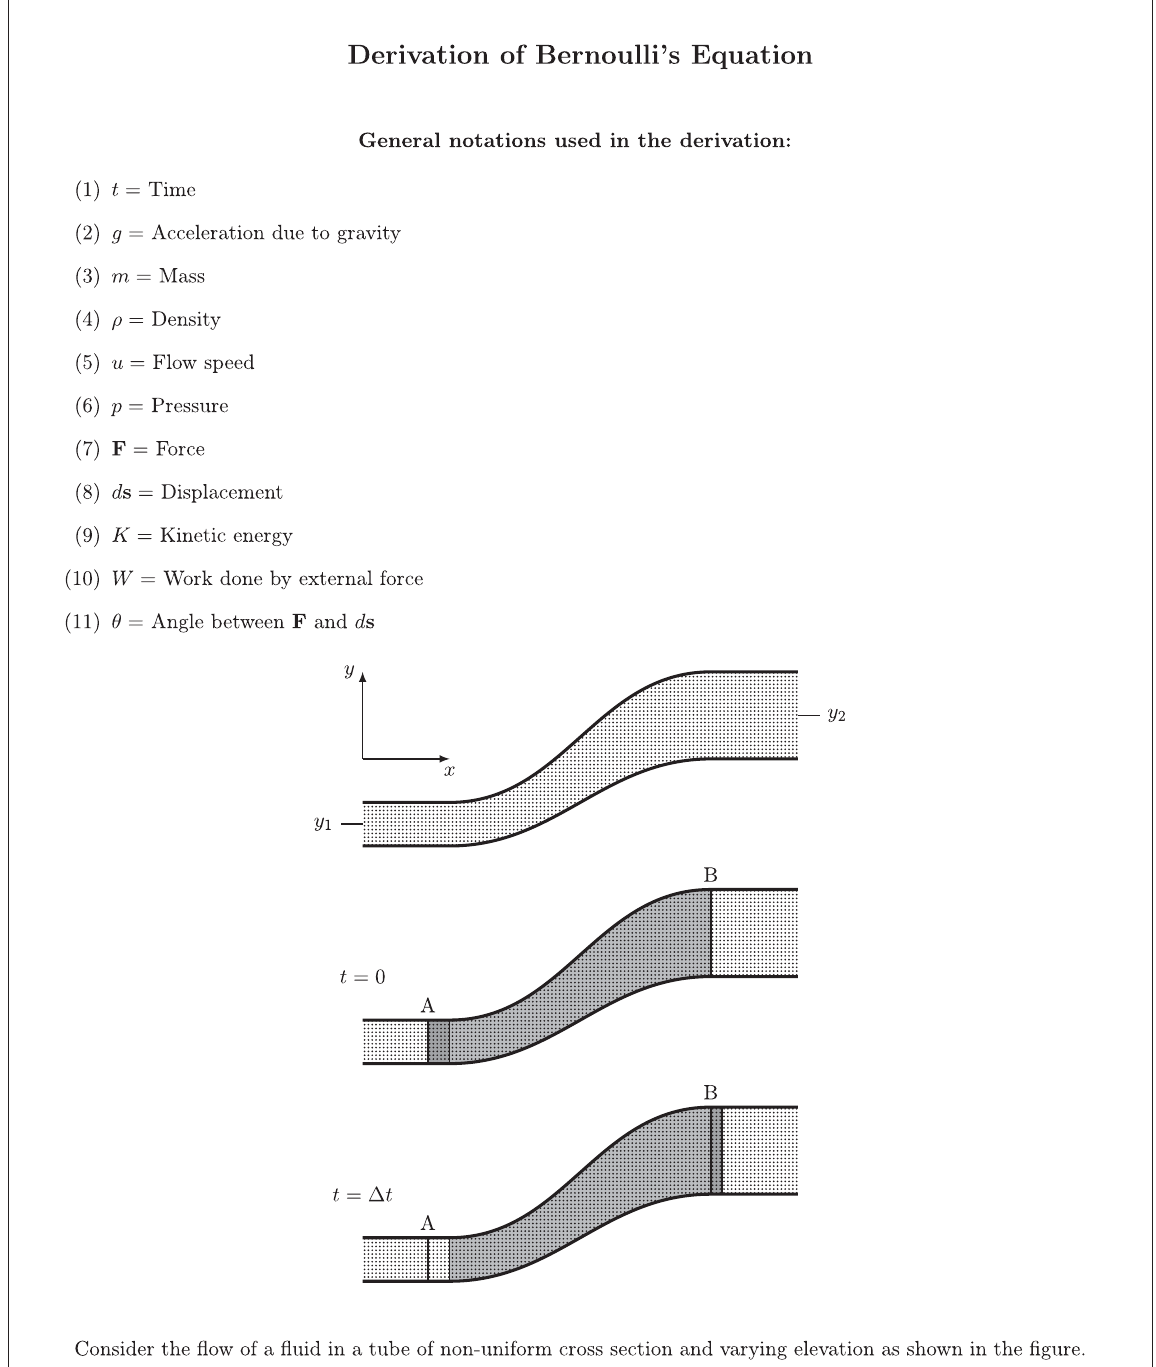
FIG. 16. Diagnostic tool for epistemic understanding: (III) Derivation of Bernoulli ’ s equation (part 1). Next parts of the tool in Figs. 17 and